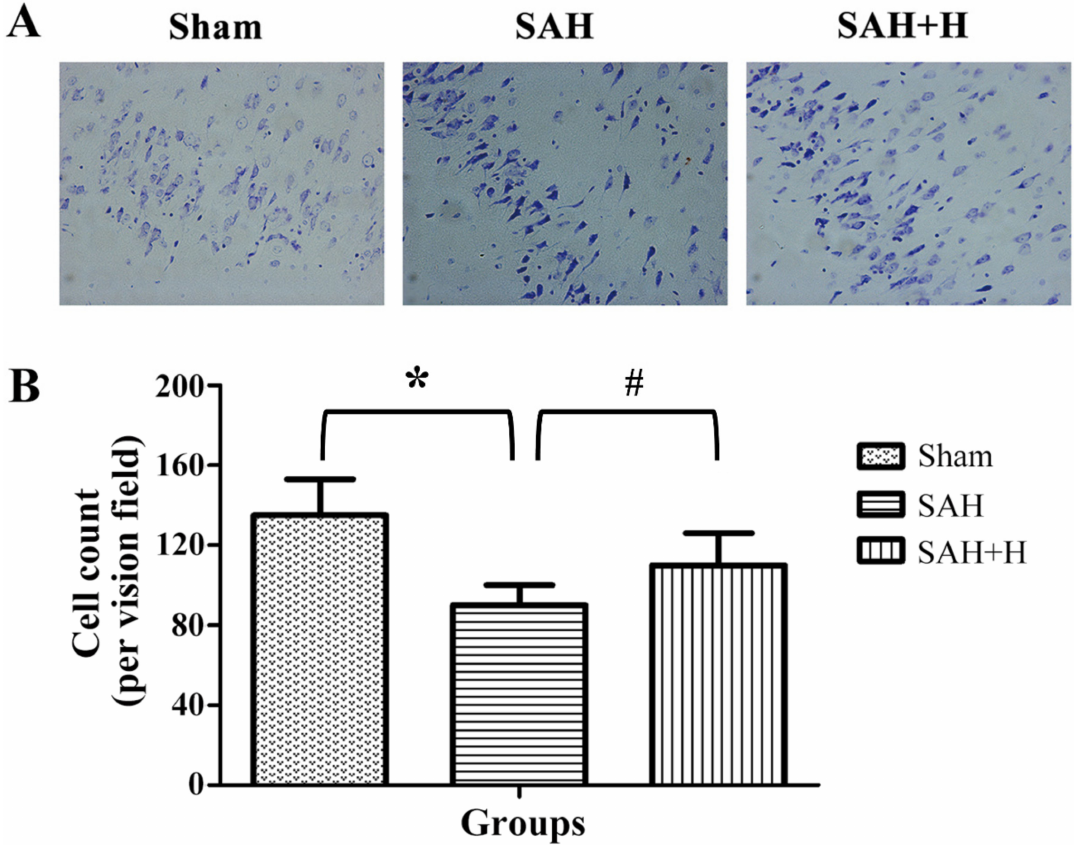
Figure 3. The Nissl staining of the temporal cortex paraffin sections 3 d after SAH. ( A ) Nissl staining images; ( B ) The numbers of surviving neurons as determined by microscopy ( × 400) and cell counting. * p < 0.05 SAH vs. Sham, # p < 0.05 SAH vs. SAH +